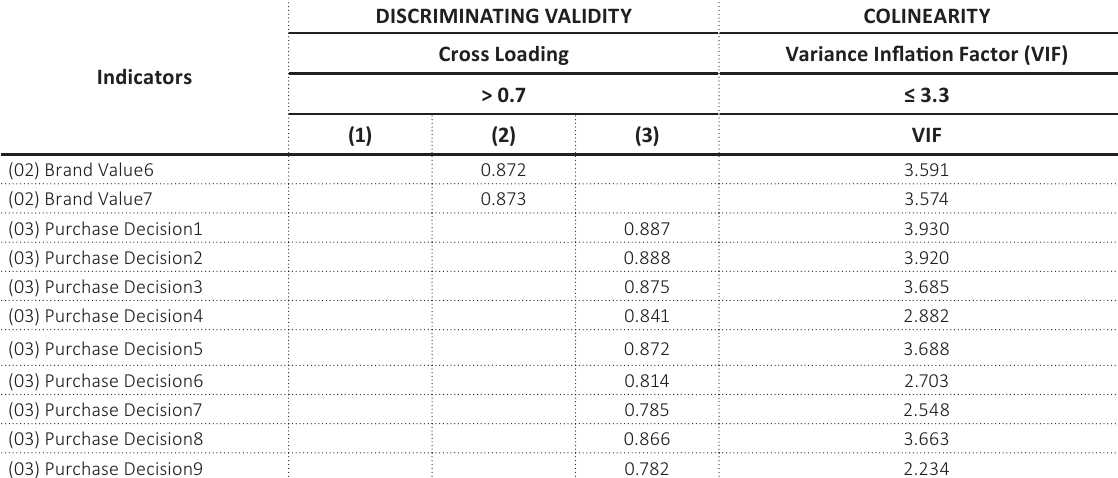
Table 3 (cont.). Indicator analysis, discriminant validity, and collinearity